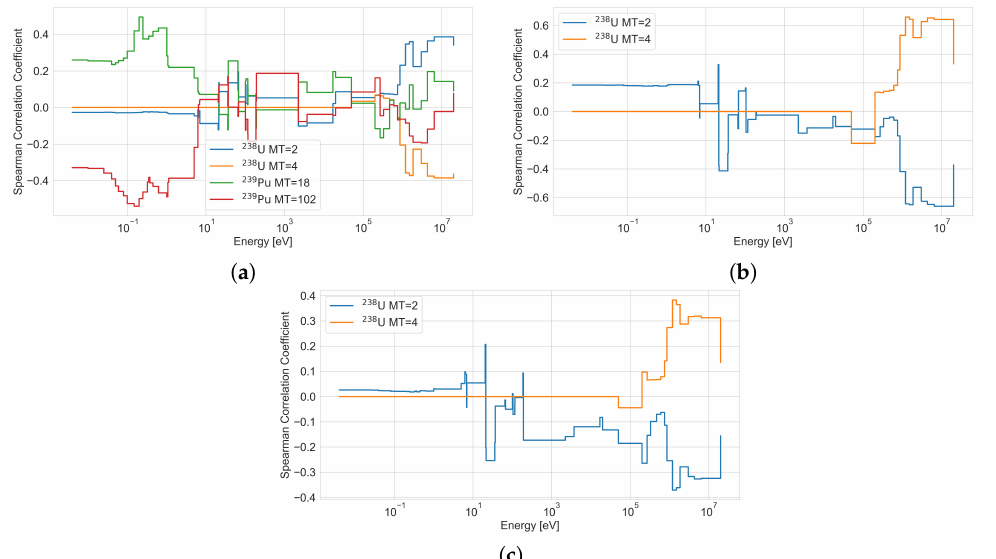
Figure 28. Statistically significant cross-sections Spearman correlation coefficients for ( a ) k eff , ( b ) P max and ( c ) T max . fc